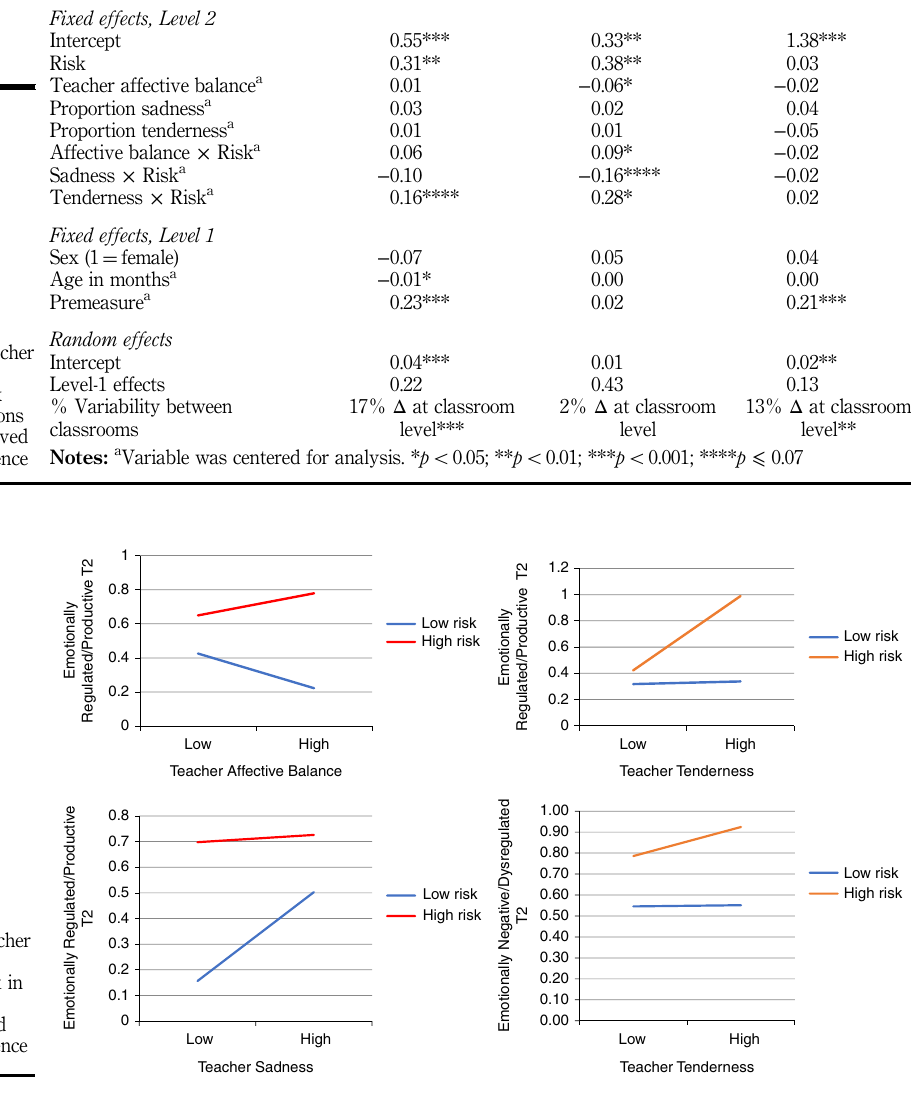
Figure 1. Interactions of teacher emotions and socioeconomic risk in contributing to children ’ s observed emotional